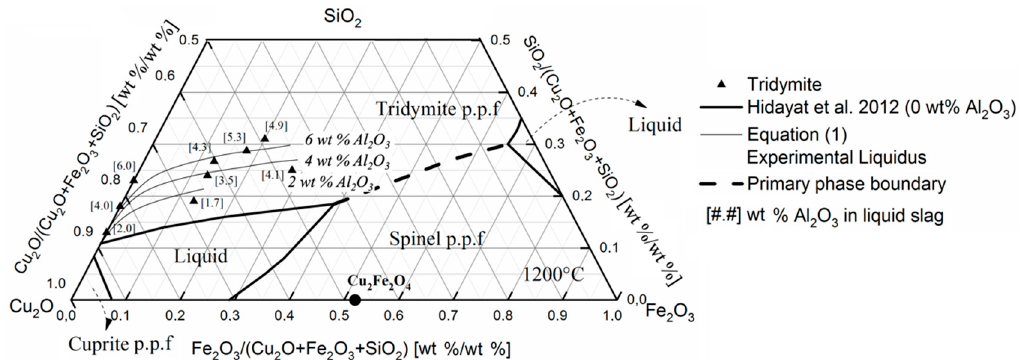
Figure 8. Liquidus for the equilibrium slag / tridymite of the Cu 2 O–Fe 2 O 3 –SiO 2 system with additions of Al 2 O 3 at 1200 °C, in equilibrium with metallic copper.